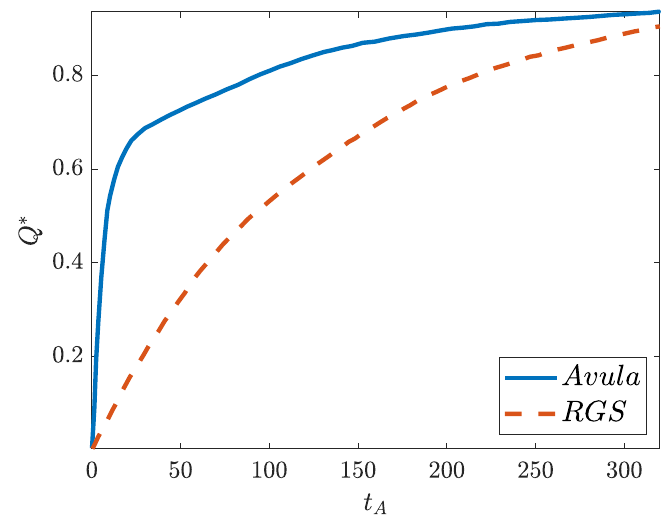
Figure 7. Time variation of discharge.